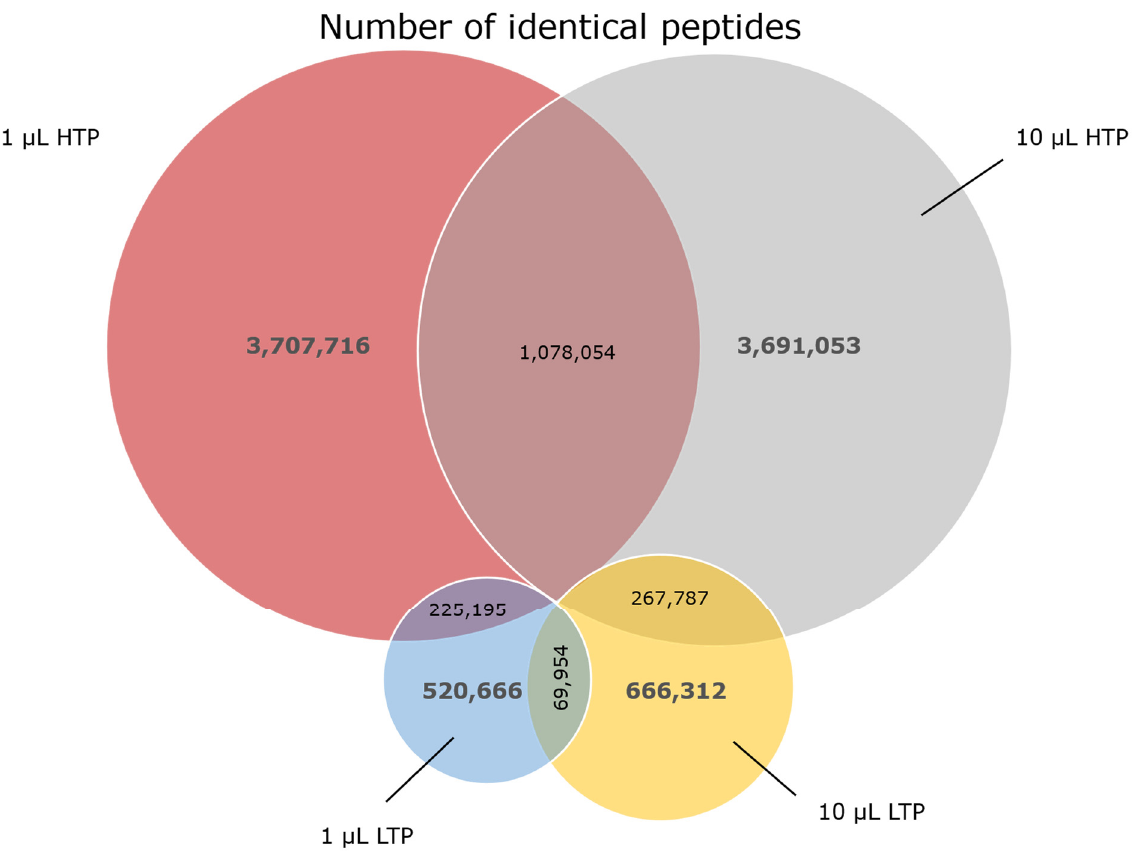
Figure 3. Illustration of the number of identical peptides between different datasets. A Venn diagram showing the number of identical peptides was made to compare samples with the same sequencing depth but different volumes and samples with the same volume but different sequencing depths. For each sample, the number of unique peptides is shown in grey, and the number of identical peptides is shown in black.